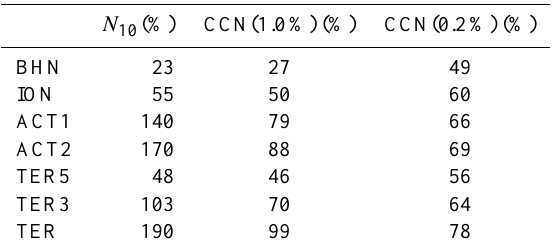
Table 3. Global-average percent increases in a given nucleation simulation compared to a simulation with no nucleation. Values are averaged for boundary layer only. See also Figs.